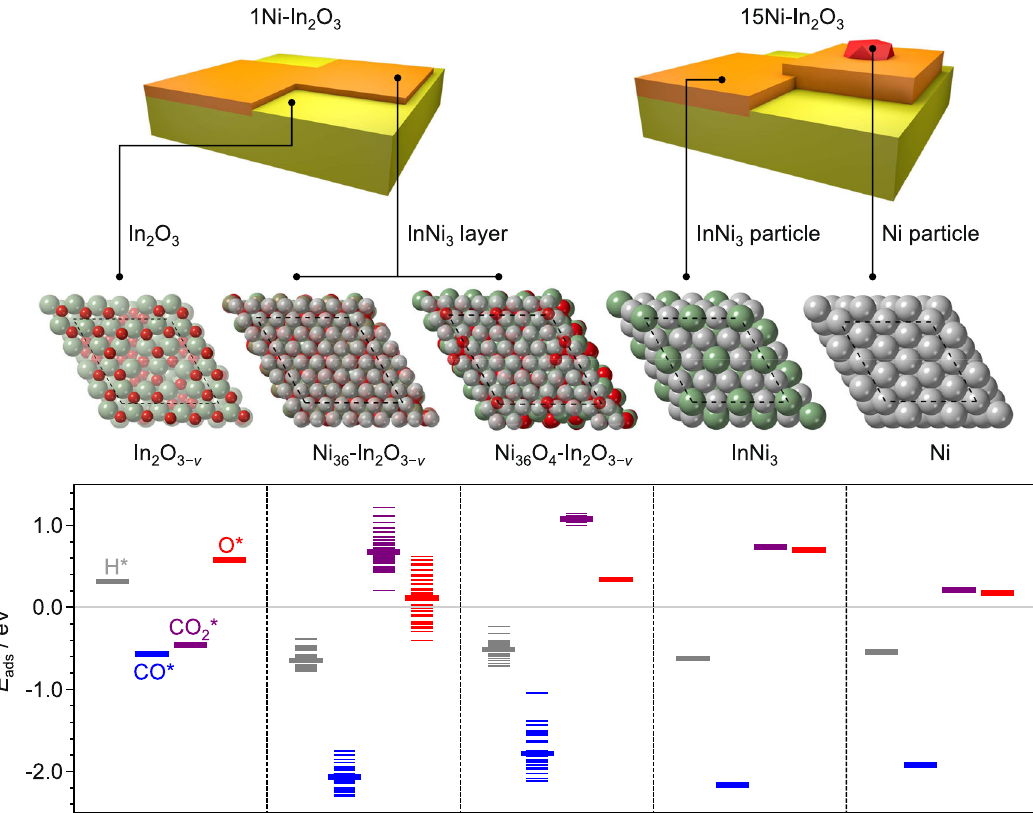
Fig. 5 Adsorption energies of reaction species on nickel-promoted In 2 O 3 catalysts. Visualization of the structures of Ni-In 2 O 3 catalysts with 1 and 15 wt.% nickel content loading (top), surfaces representative of the different catalyst constituents generated by DFT (middle), and adsorption energies ( E ads ) of species relevant to the reaction associated with them (bottom). The multiple energy levels for individual species for models containing nickel layer relate to the presence of a distinct number of oxygen atoms. The subscript v stands for vacancy. CO 2 adsorption at the boundary between unpromoted In 2 O 3 (111) and a strip of Ni(111) (layer equivalent to Ni 36 -In 2 O 3 − v ) is shown in Supplementary Fig.